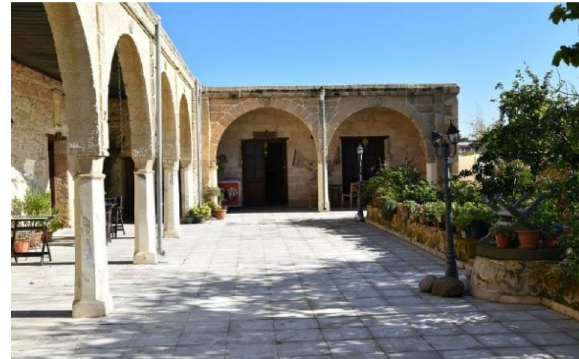
Fig. 14 Revakl ı Ev Guest House. An example of a portico and arched structure — Risokarpaso.